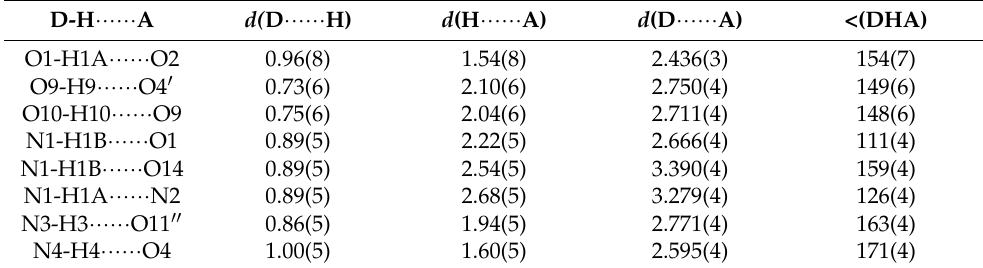
Table 3. Intra and intermolecular hydrogen bond data (Å, ◦ )